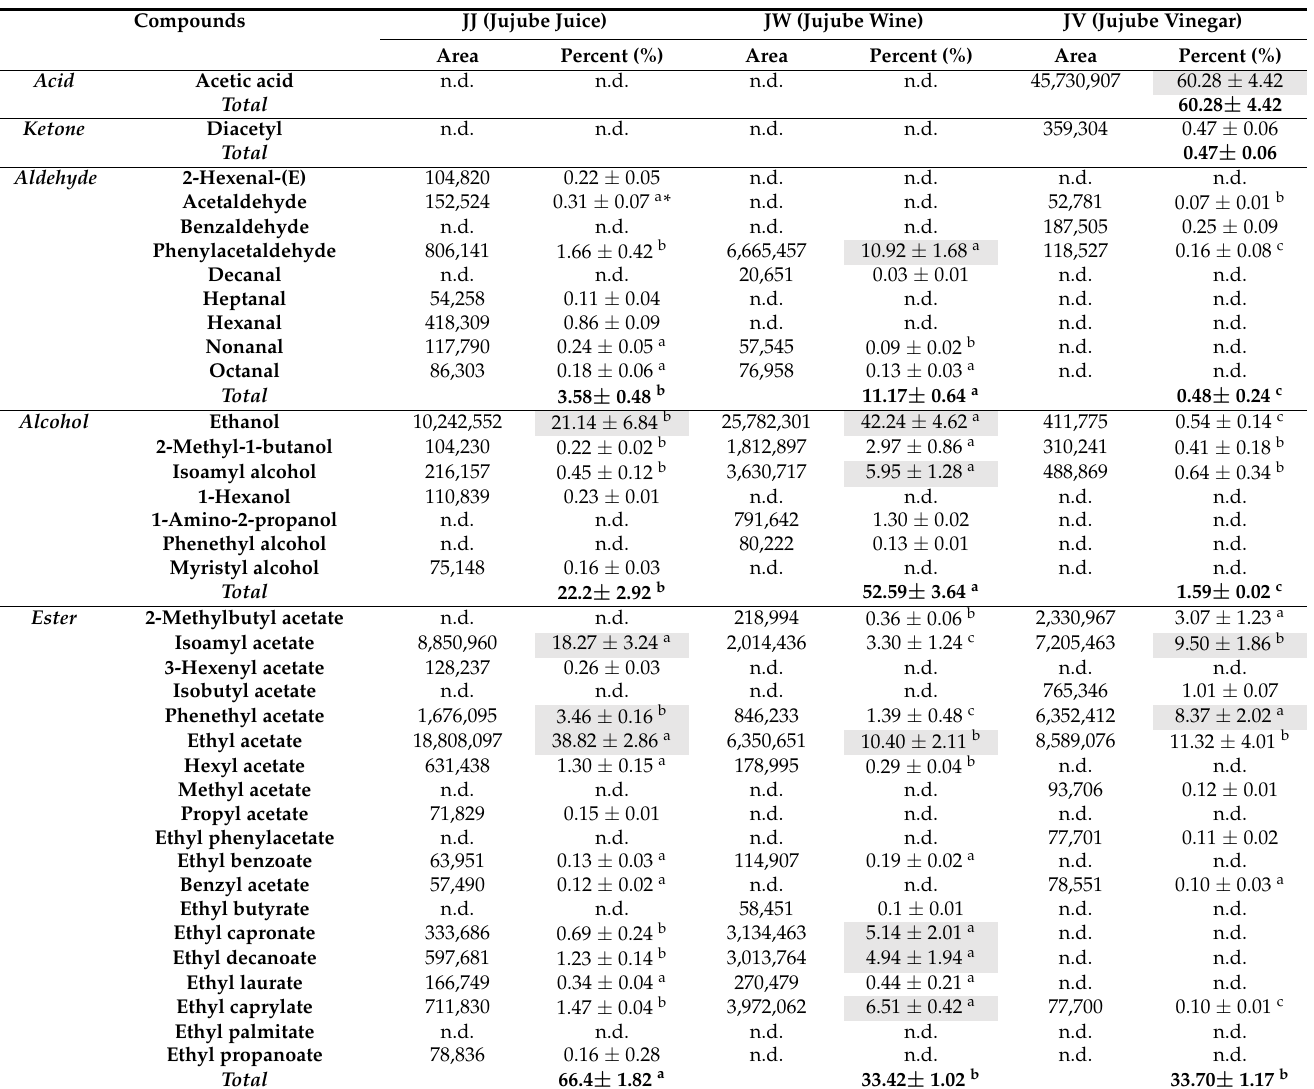
Table 4. The changes in volatile compounds associated with aroma during fermentation in the production of jujube